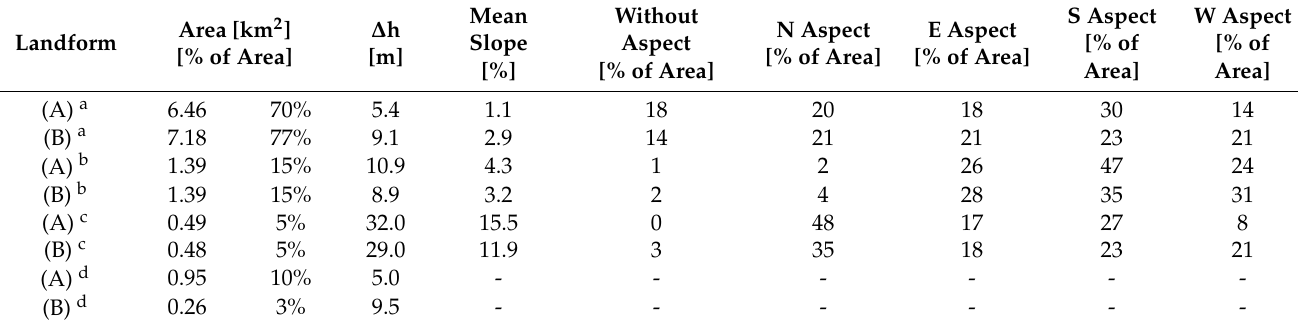
Table 3. Topographic parameters of main landforms (a–d), in time variant (A),(B), based on the third method.